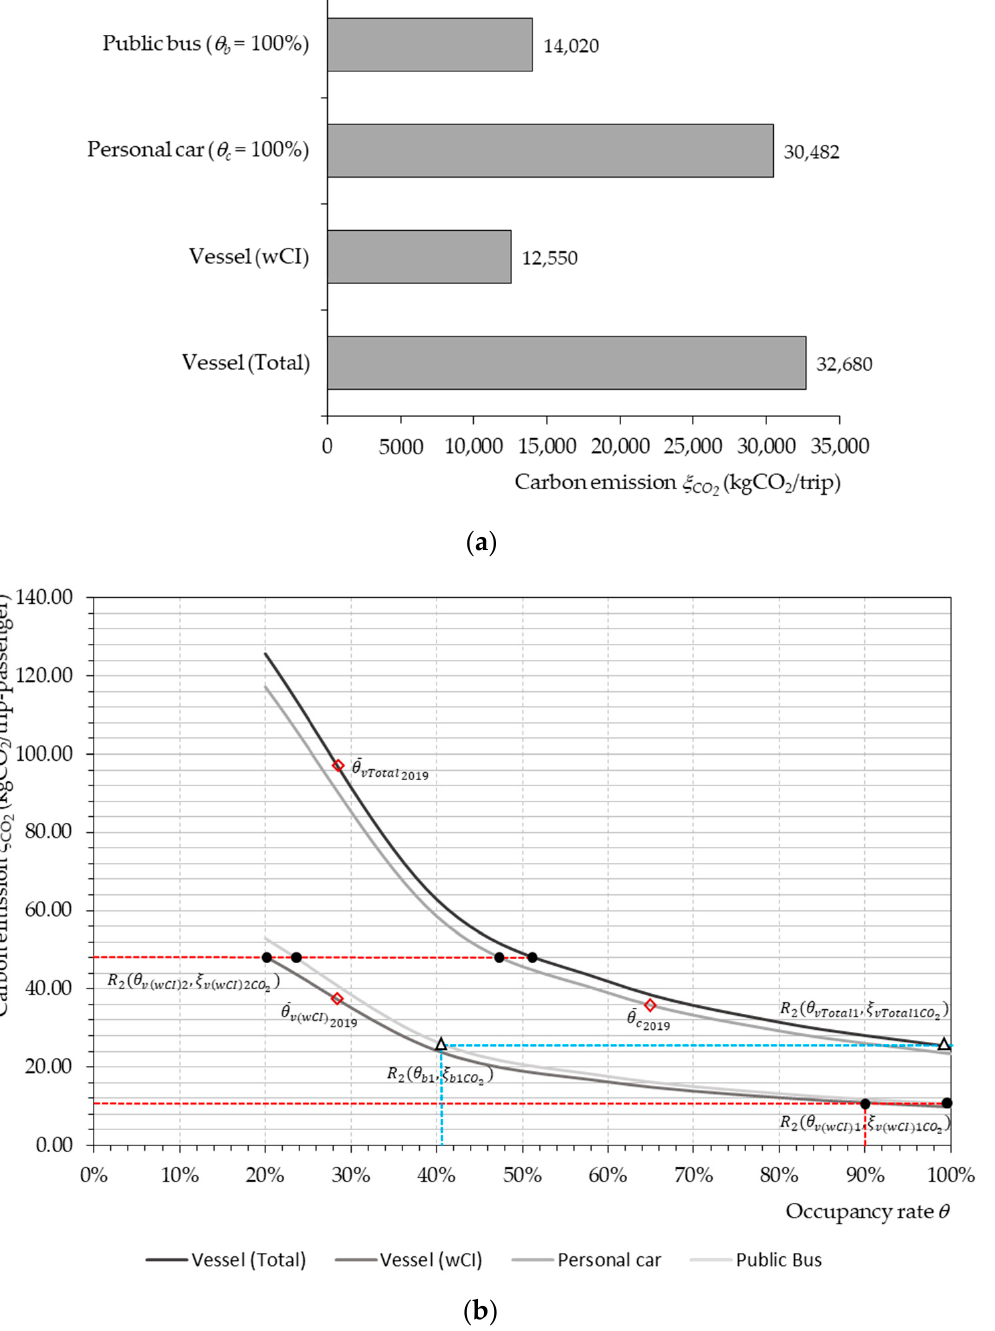
Figure 11. Calculated carbon emissions on the route R 2 : ( a ) total carbon emissions per single trip with respect to each transportation mode and based on the reference capacity of 1300 passengers; ( b ) comparison of carbon emissions with respect to the 𝜃 for each transportation mode choice.